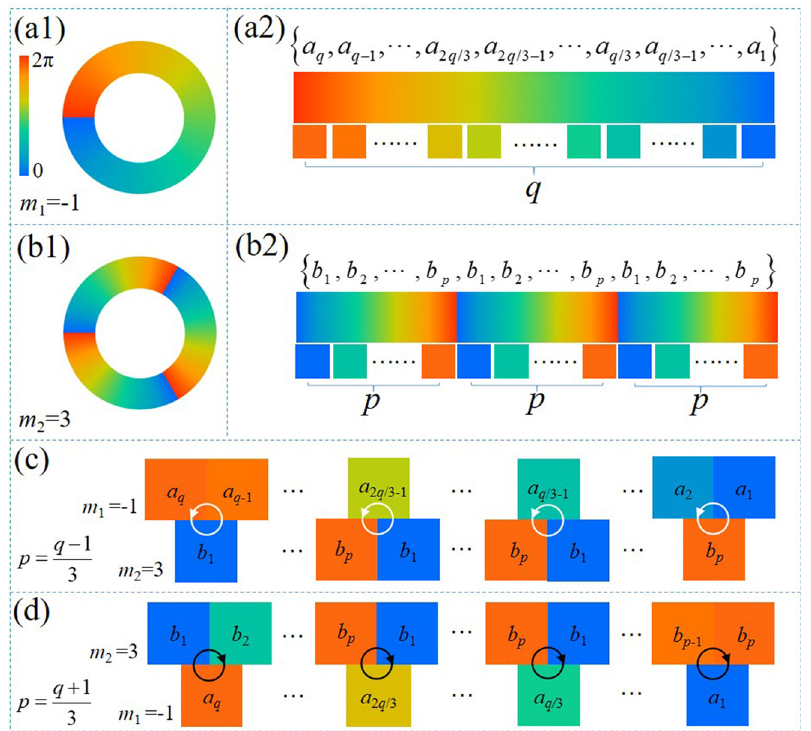
Figure 1: Schematic illustration of why TC of the unit OVs in OVL is always ± 1. (a1)And(b1)OVbeamswithTCsof − 1 and3, respectively. (a2) And (b2) horizontal expansion and discrete arithmetic sequences. (c) And (d) superposition in two different cases, and the white and black circle arrows represent the negative and positive unit OVs,